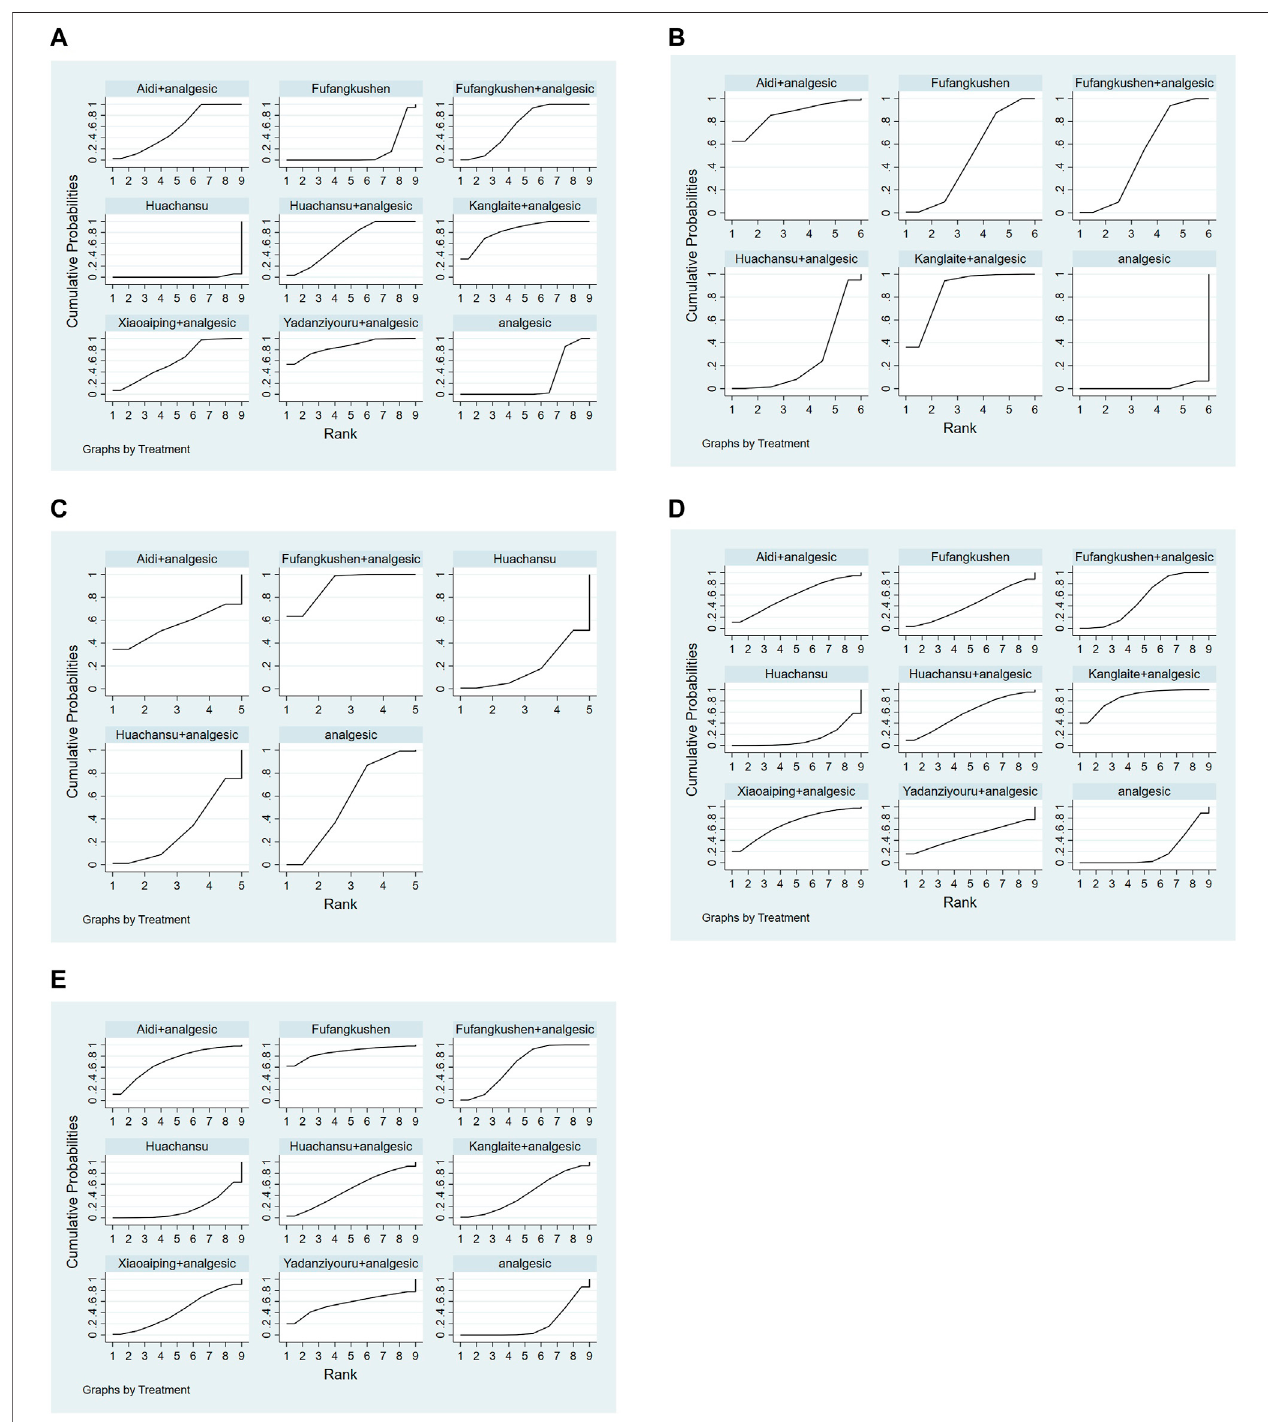
FIGURE 4 | Plot of the surface under the cumulative ranking curves for all treatments. (A) Pain relief rate; (B) KPS; (C) Total Adverse Reactions; (D) Nausea and vomiting; (E) constipation.